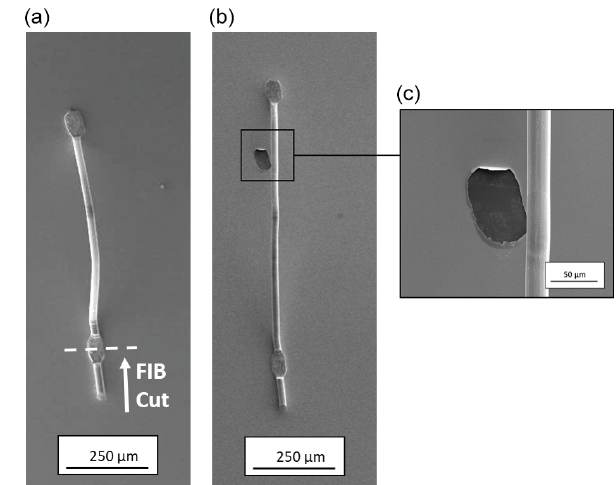
Figure 8. Wire bond on Pt thin film before (a) and after (b) thermal ageing for 6h at 800 ◦ C and wire pull test (c) , with delamination of the metallisation.